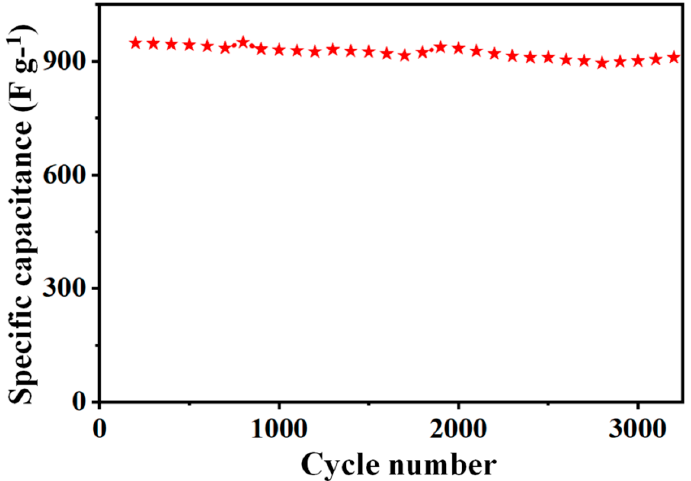
Figure 7. Cycling stability of the sulfur-deficient NiCo 2 S 4 nanosheet composites over 3500 long cy- cles at a constant current density of 3 A g − 1 . at a constant current density of 3 A g − 1